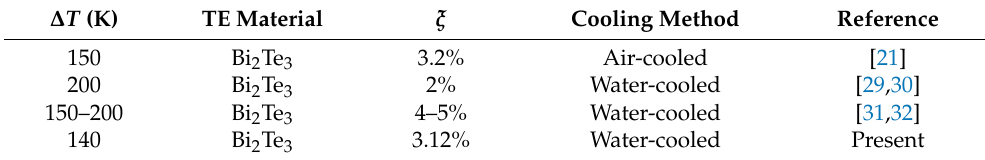
Table 5. TE efficiency of various SPTEGs.